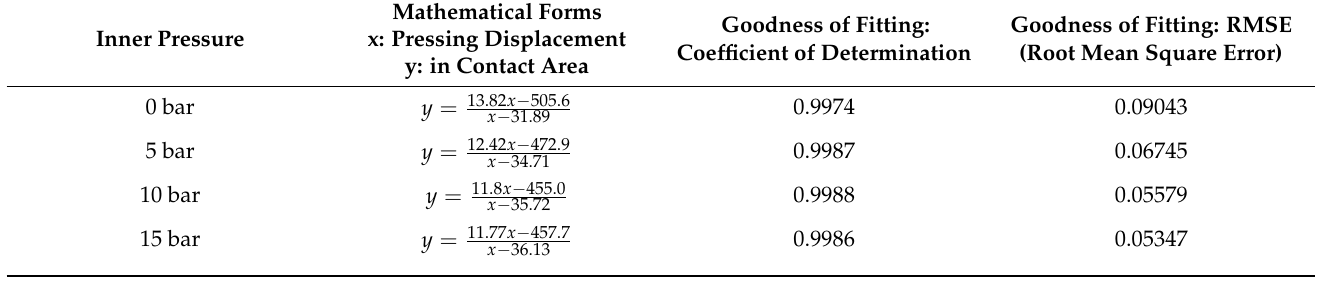
Figure 16. The area in contact of the hose inner surface when the pressing displacement is 35.20 mm, 37.26 mm, 39 mm and 40 mm, while the inner pressure is zero. The contour plot of CPRESS shows the in-contact area.